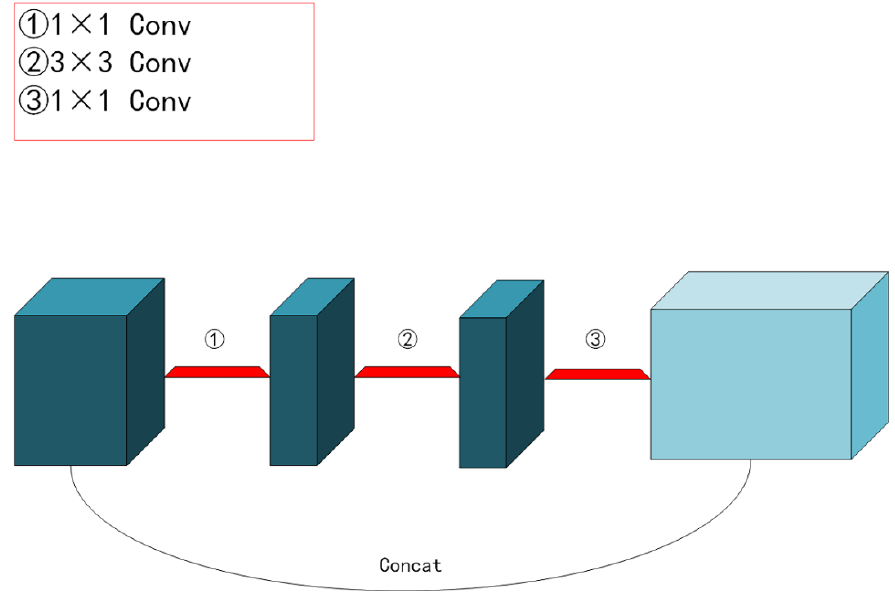
Figure 4. Traditional residual structure.